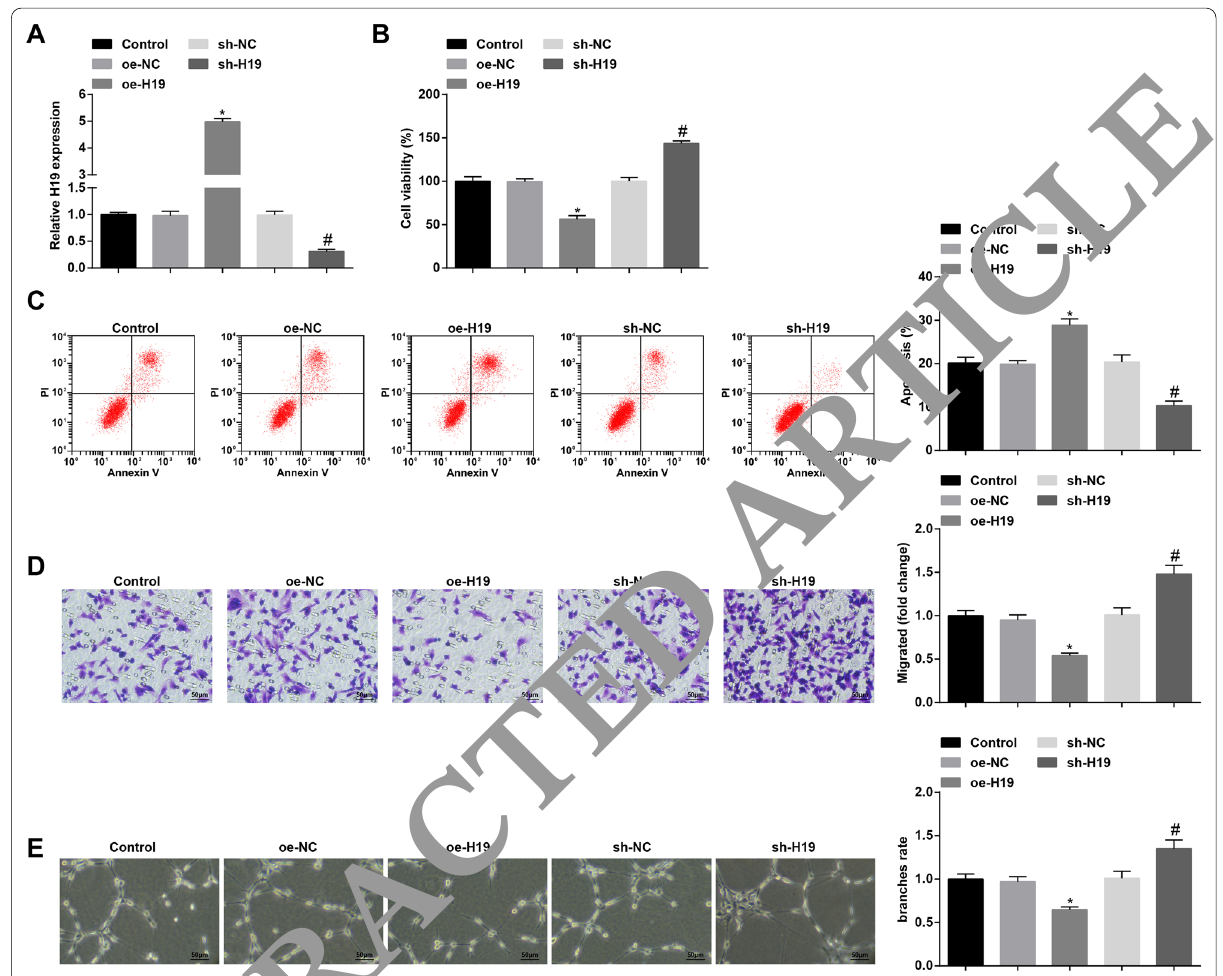
Fig. 2 H19 knockdown represses apoptosis and improves migration and angiogenesis of OGD-induced BMECs. A H19 expression in sh-H19- or oe-H19-transfected and OGD-induced BMECs detected by RT-qPCR; B Viability of sh-H19- or oe-H19-transfected and OGD-induced BMECs detected by MTT assay; C Apoptosis of sh-H19- or oe-H19-transfected and OGD-induced BMECs detected by flow cytometry; D Cell migration of sh-H19- or oe-H19-transfected and OGD-induced BMECs detected by Transwell assay; E Angiogenesis of sh-H19- or oe-H19-transfected and OGD-induced BMECs detected by Matrigel method; N 3; * P < 0.05 compared with the oe-NC group; # P < 0.05 compared with the si-NC group. The data were = expressed as the mean standard ±